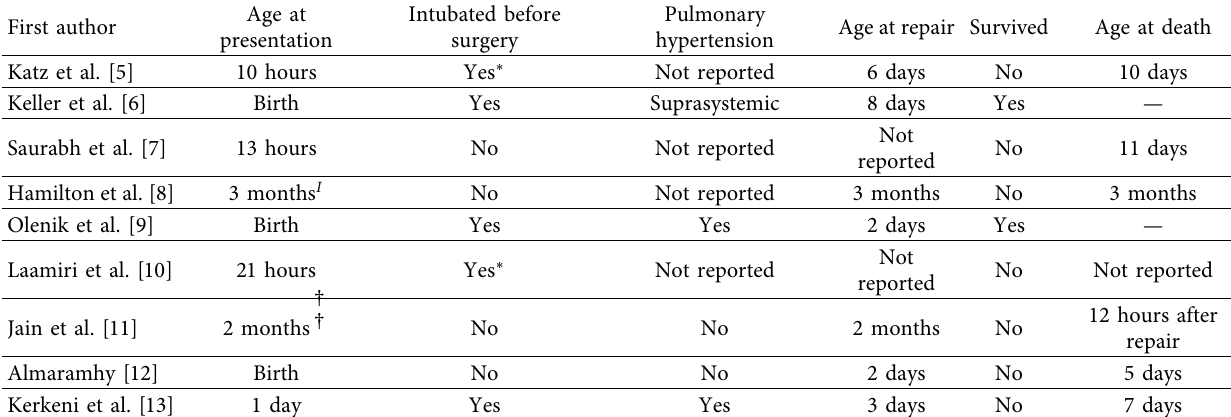
Figure 3: Follow-up radiograph at 5 months of age. (a) Anterior-posterior view suggesting minimal right lung aeration. (b) Lateral view showing the different locations of the two diaphragms, suggesting profound right pulmonary hypoplasia. Table 1: Summary of nine similar